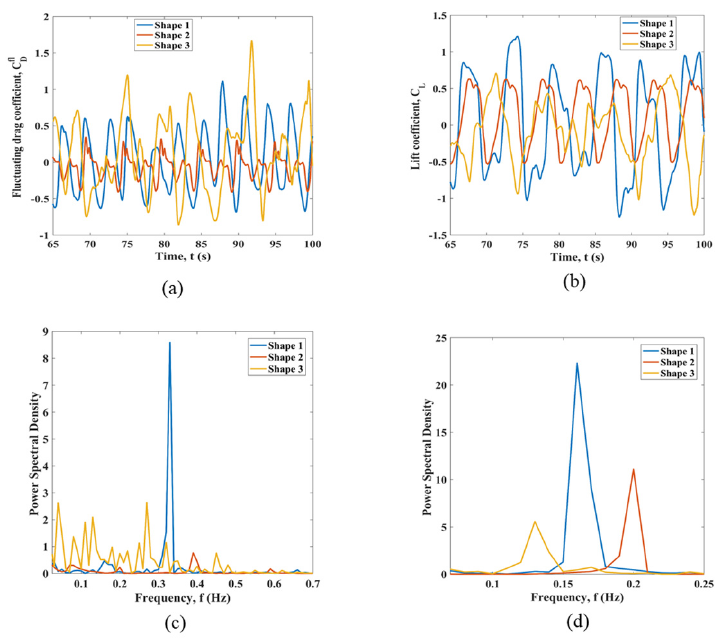
Figure A11. Fluid force coefficients for cylinder 2 immersed in uniform flow: ( a ) time history of the fluctuating drag coefficient; ( b ) time history of the lift coefficient; ( c ) the fluctuating drag coefficient FFT; ( d ) the lift coefficient FFT.